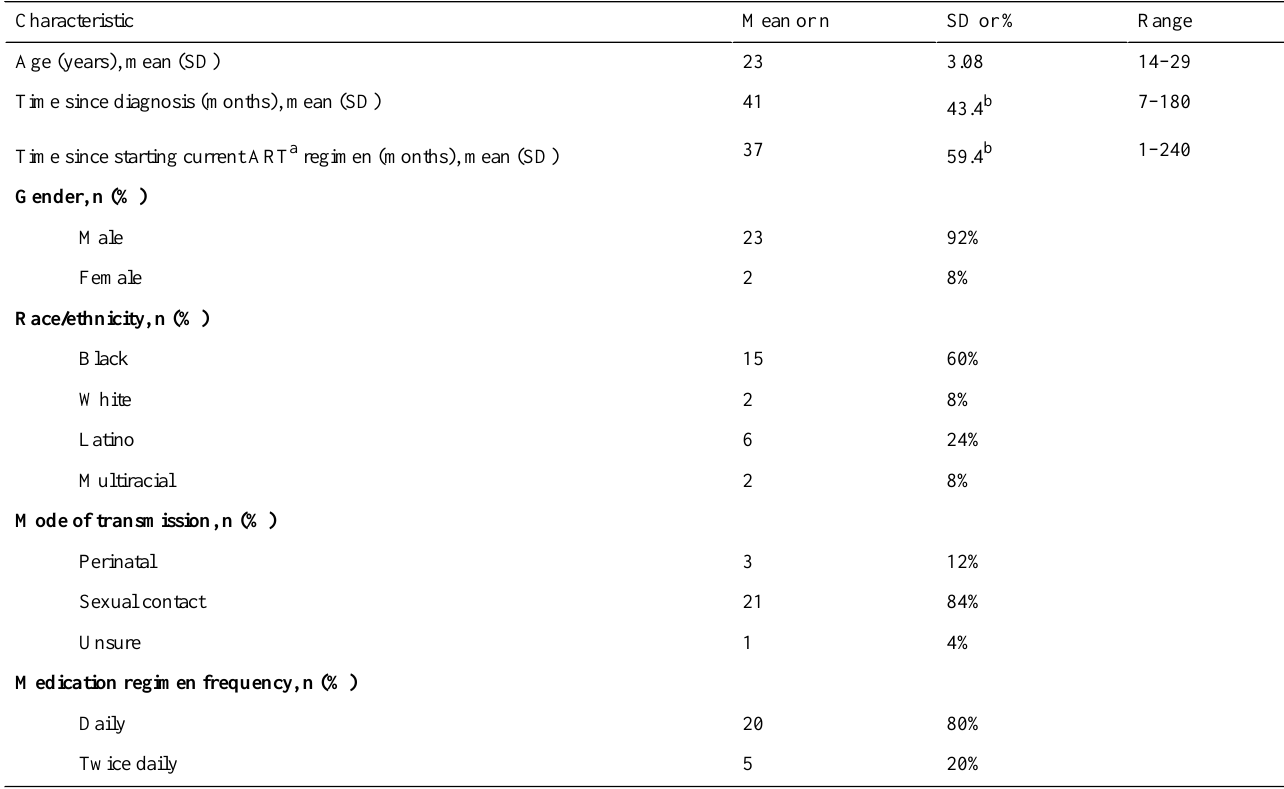
Table 1. Participants’demographics characteristics (n = 25).